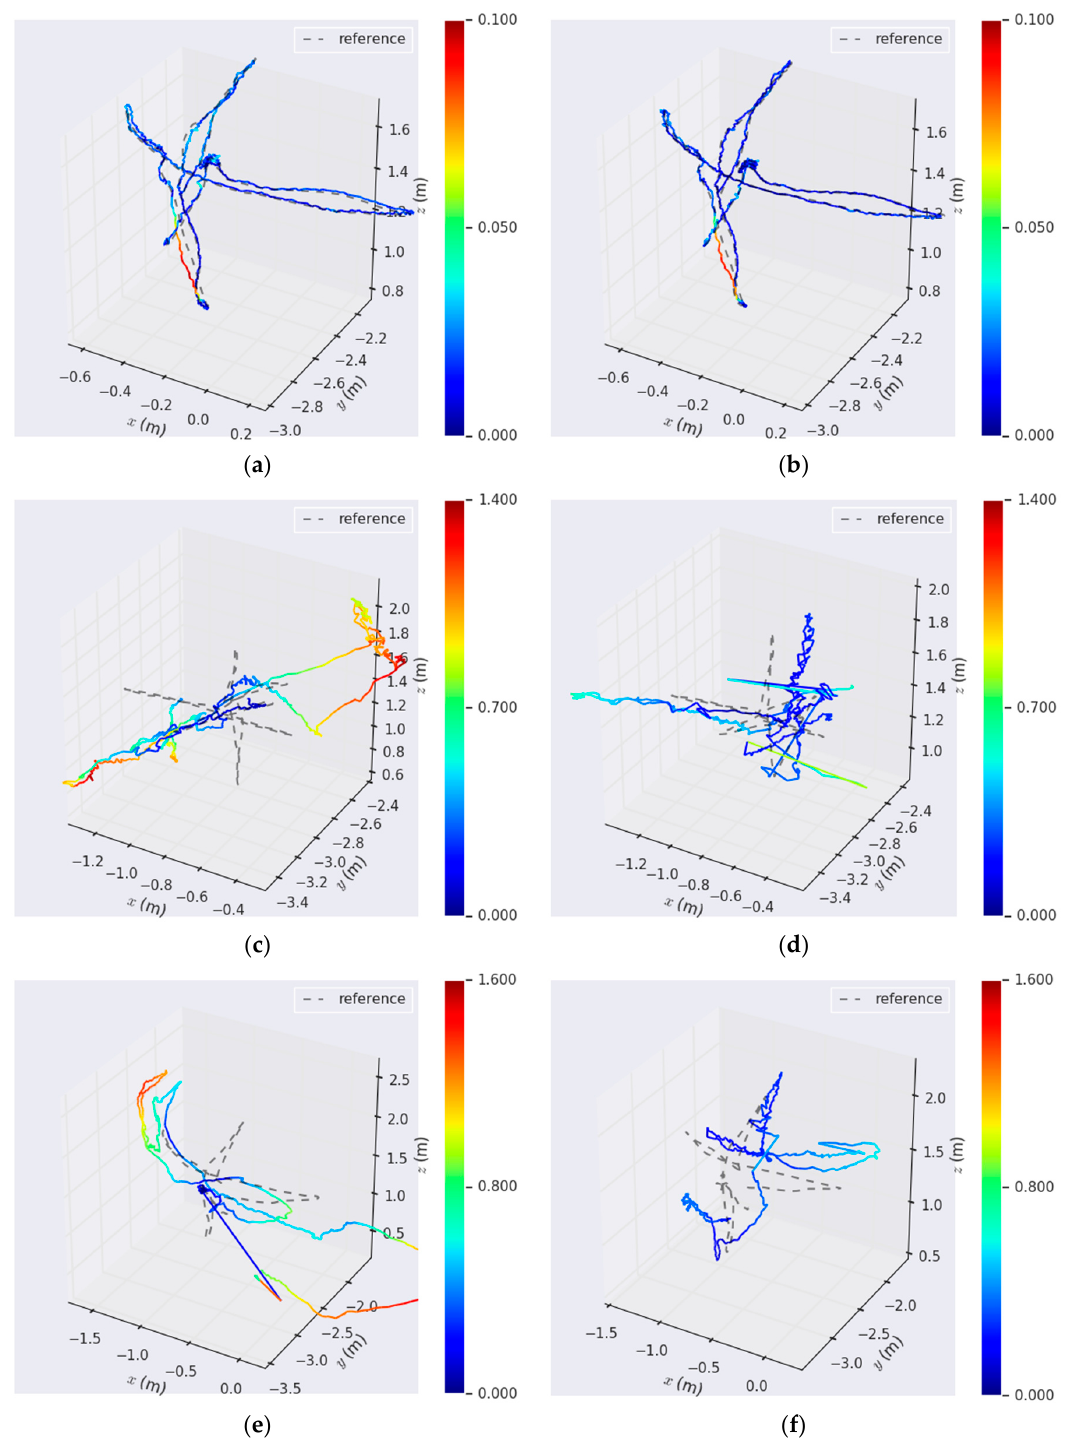
Figure 13. Several accuracy heat maps of the proposed RGB-D SLAM with and without our moving object detection method. The three accuracy heat maps of the left column were estimated without using the moving object detection method on the ( a ) fr3 / sitting_halfsphere , ( c ) fr3 / walking_xyz , and ( e ) fr3_walking_halfsphere sequences. The three accuracy heat maps of the right column were estimated using the method on the ( b ) fr3 / sitting_halfsphere , ( d ) fr3 / walking_xyz , and ( f ) fr3_walking_halfsphere sequences. The two color bars of each row have the same maximum error and minimum error. The redder the color is, the larger the ATE